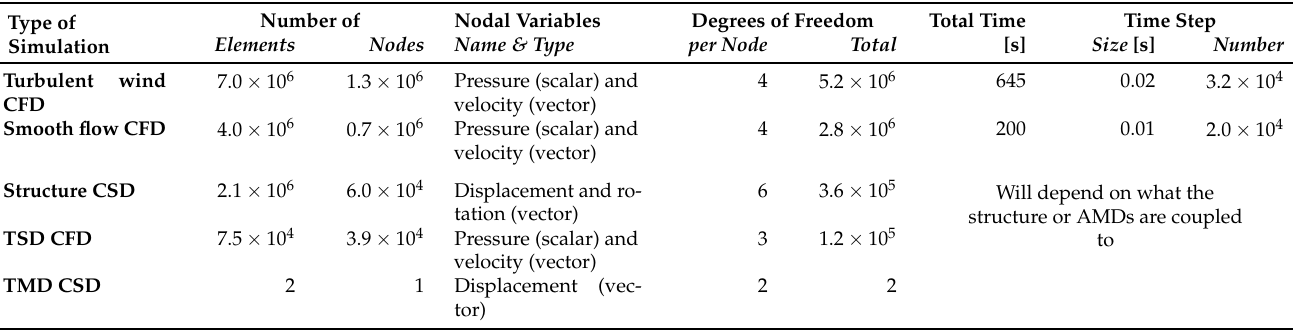
Table 5. Complexity of the numerical